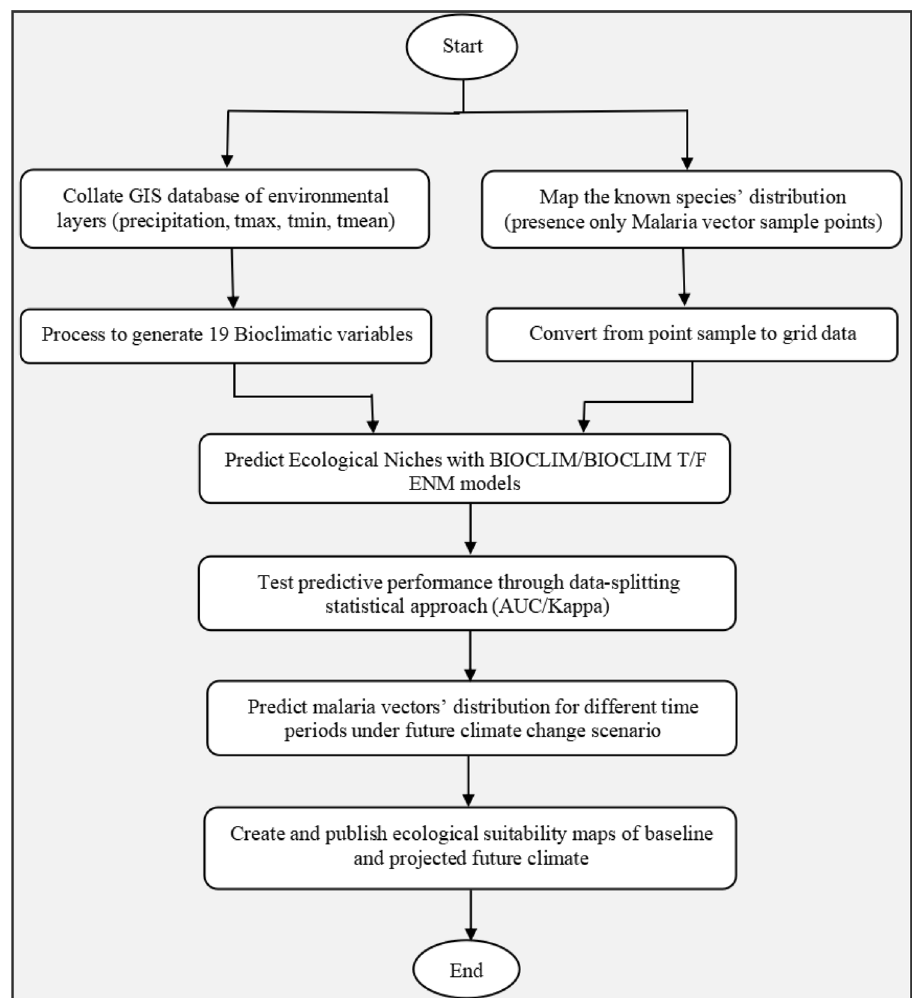
Fig. 2 Flow diagram for cor- relative malaria vector distribu- tion